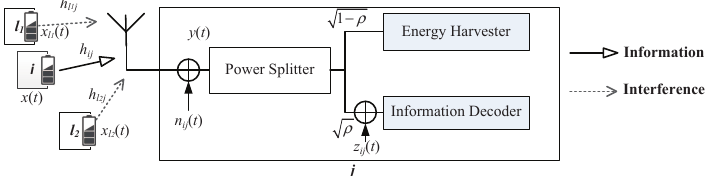
Figure 4. Simultaneous wireless information and power transfer (SWIPT)